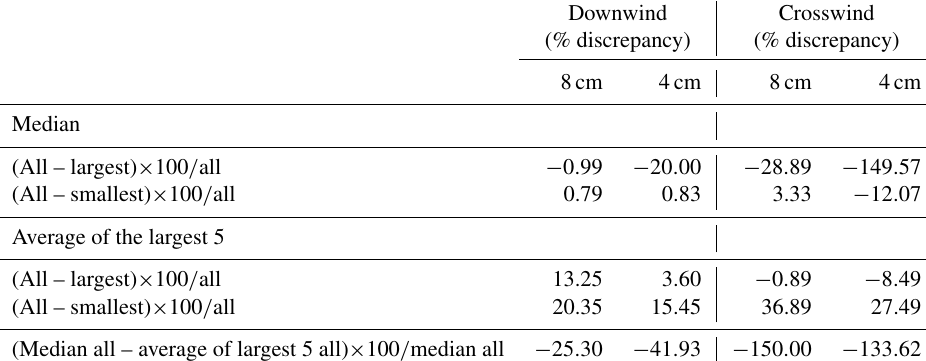
Table A2. Percentage discrepancy amongst downwind and crosswind distances of individual contours (as defined by Carey and Sparks, 1986) for the isopleth maps of Fig. A1. All: median or average of five clast values calculated considering all clasts from the three areas of individual outcrops (30–45 clasts). Largest: largest median or average of five clast values of the three areas (with 10–15 clasts within each area). Smallest: smallest median or average of five clast values of the three areas (with 10–15 clasts within each